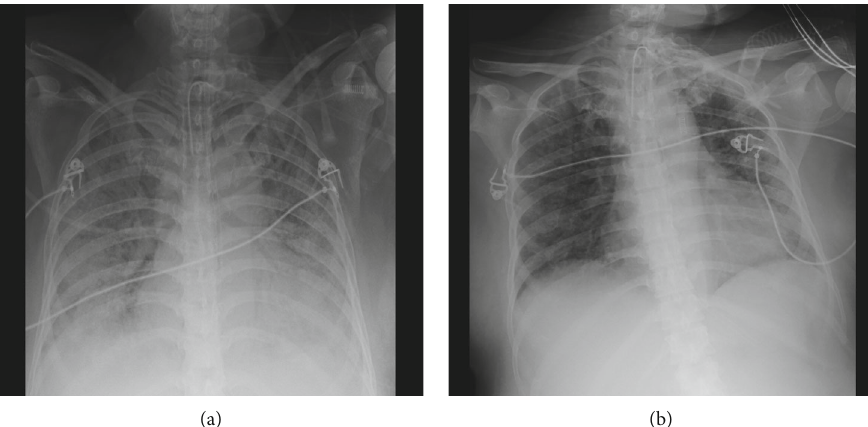
Figure 3: Chest X-ray. (a) A week after the fi rst extracorporeal membrane oxygenation weaning. Bilateral pneumonia is shown. (b) After the second decannulation of extracorporeal membrane oxygenation. Partial resolution of bilateral pneumonia with persistence of di ff use loss of aeration is